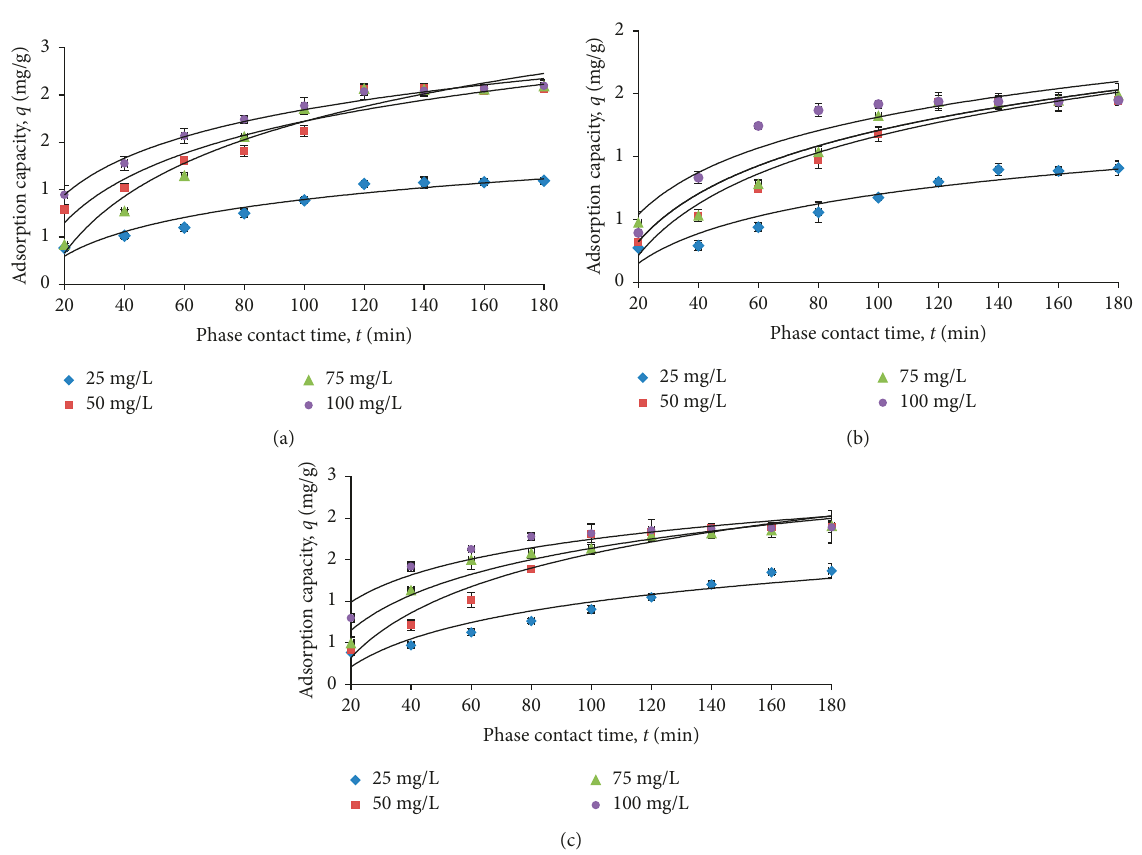
Figure 2: Kinetic of (a) rutin, (b) scopoletin, and (c) quercetin adsorption onto a weak-base ion exchange resin (Amberlite IRA 67) at different phenolic compound concentrations. Graph represents the mean of three replicate samples with error